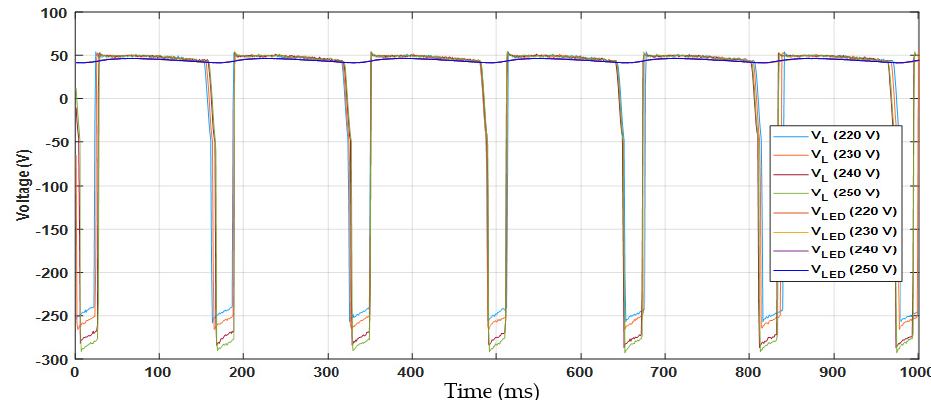
Figure 12. The voltage across the reactance (V L ) and the voltage across the LEDs (V LED ) for four different mains voltages, Type A lamp.